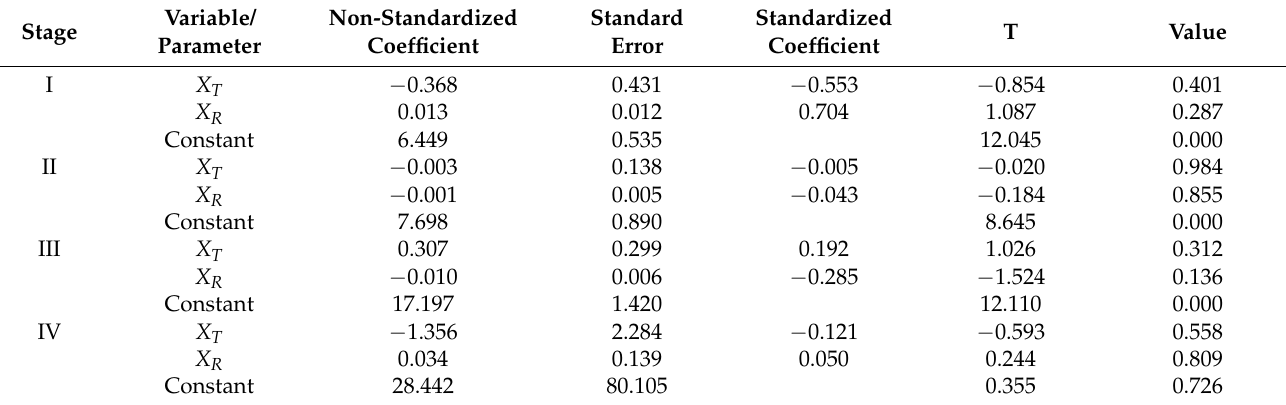
Table A2. Cochrane–Orcutt estimation results: Regression